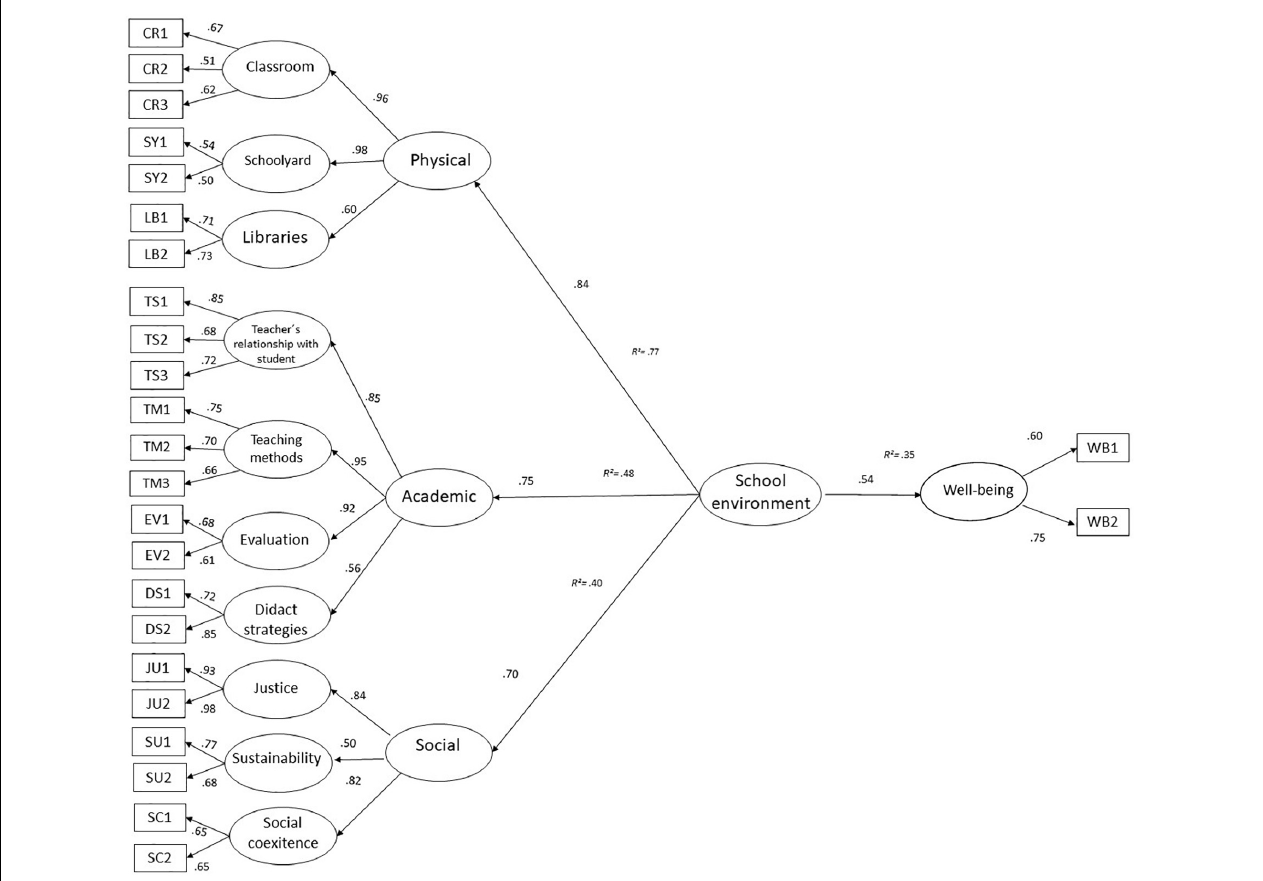
FIGURE 2 | Structural model of the relationship between school environment and well-being. Goodness of fit: X 2 = 570.99 (307 df ), p = 0.000, BBNFI = 0.90, BBNNFI = 0.91, CFI = 0.93, RMSEA = 0.04. Well-being R 2 = 0.35.